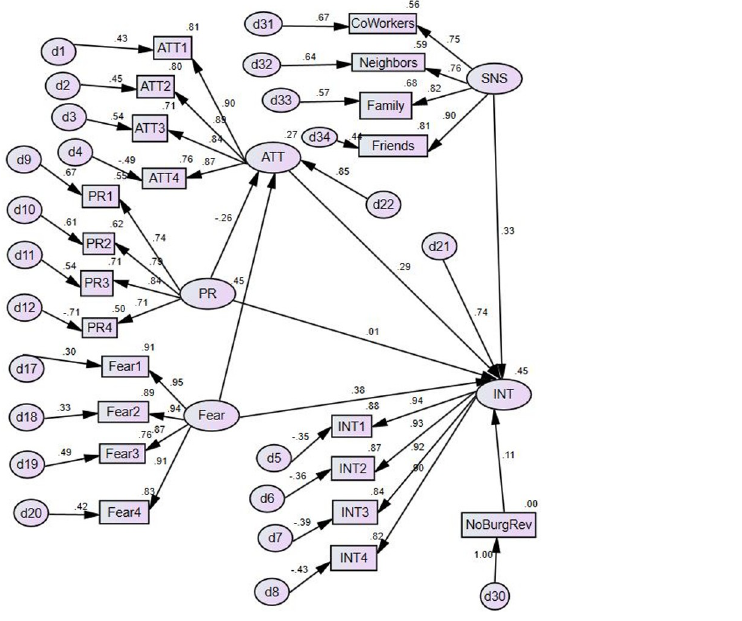
Fig 4. Evaluated mediated structural